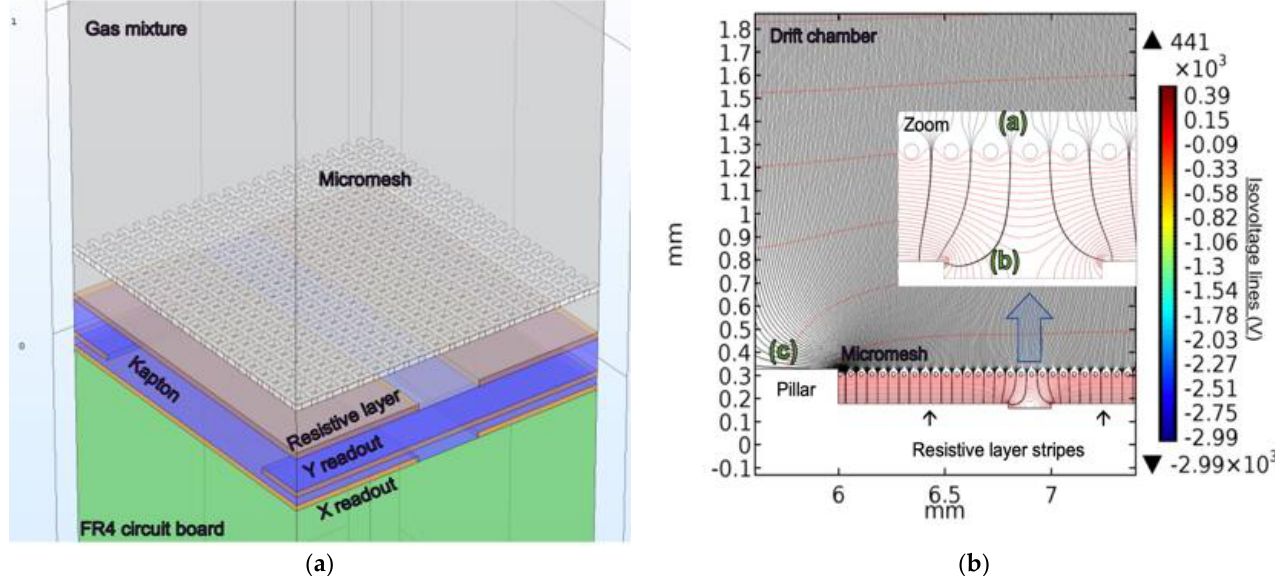
Figure 3. ( a ) Schematic representation of the unit cell of the MUST 2 detector for transparence simulations. ( b ) Electrostatic simulation near the micromesh.